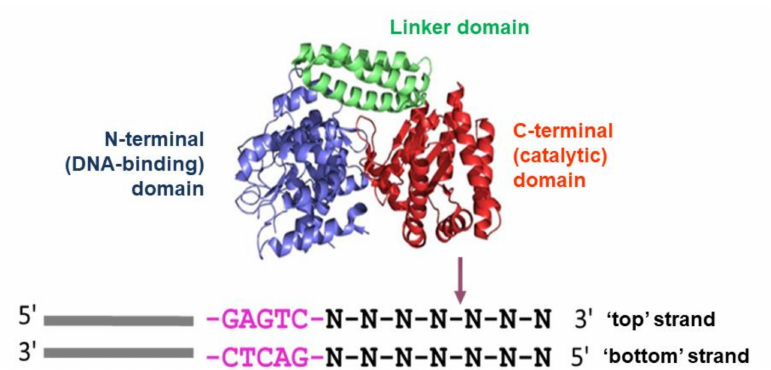
Figure 1. An outline of the domain organisation of Nt.BspD6I (Protein Data Bank ID: 2EWF), the en- zyme’s recognition site (highlighted in pink), and the cleavage site in the top DNA strand (arrow). Nt.BspD6I contains 604 amino acid residues, and its molecular mass is 70.8 kDa.